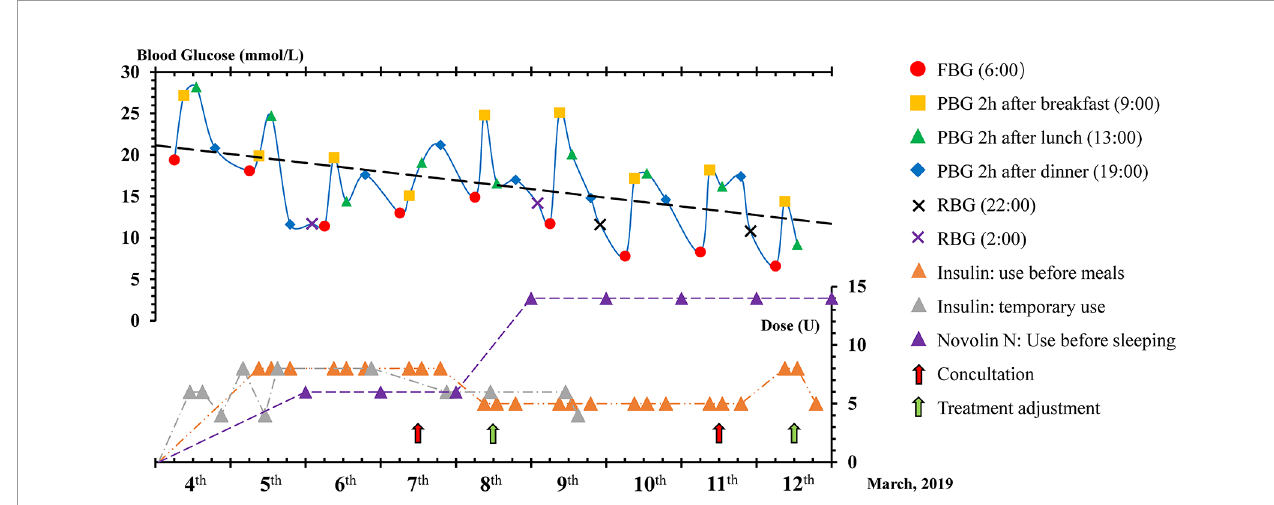
FIGURE 1 | Dynamic changes in blood glucose and insulin dosage. FPG, Fasting Blood Glucose; PBG, Postprandial Blood Glucose; RBG, Random Blood